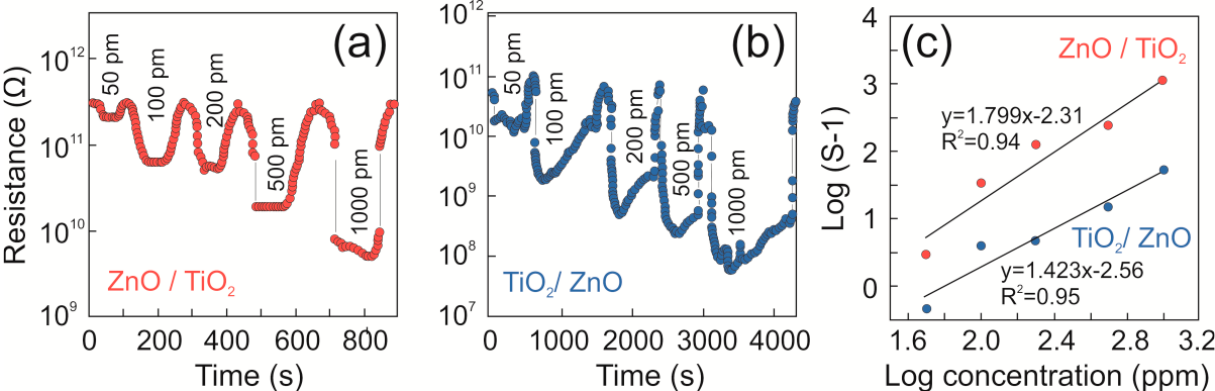
Figure 6. Transient resistance trends for samples ( a ) ZnO/TiO 2 and ( b ) TiO 2 /ZnO towards varying concentrations of ( a ) 2-propanol and ( b ) ethanol. ( c ) Logarithmic response vs. logarithmic concen- tration trends for samples ZnO/TiO 2 (dark blue markers) and TiO 2 /ZnO (red markers) towards 2-propanol and ethanol, respectively.